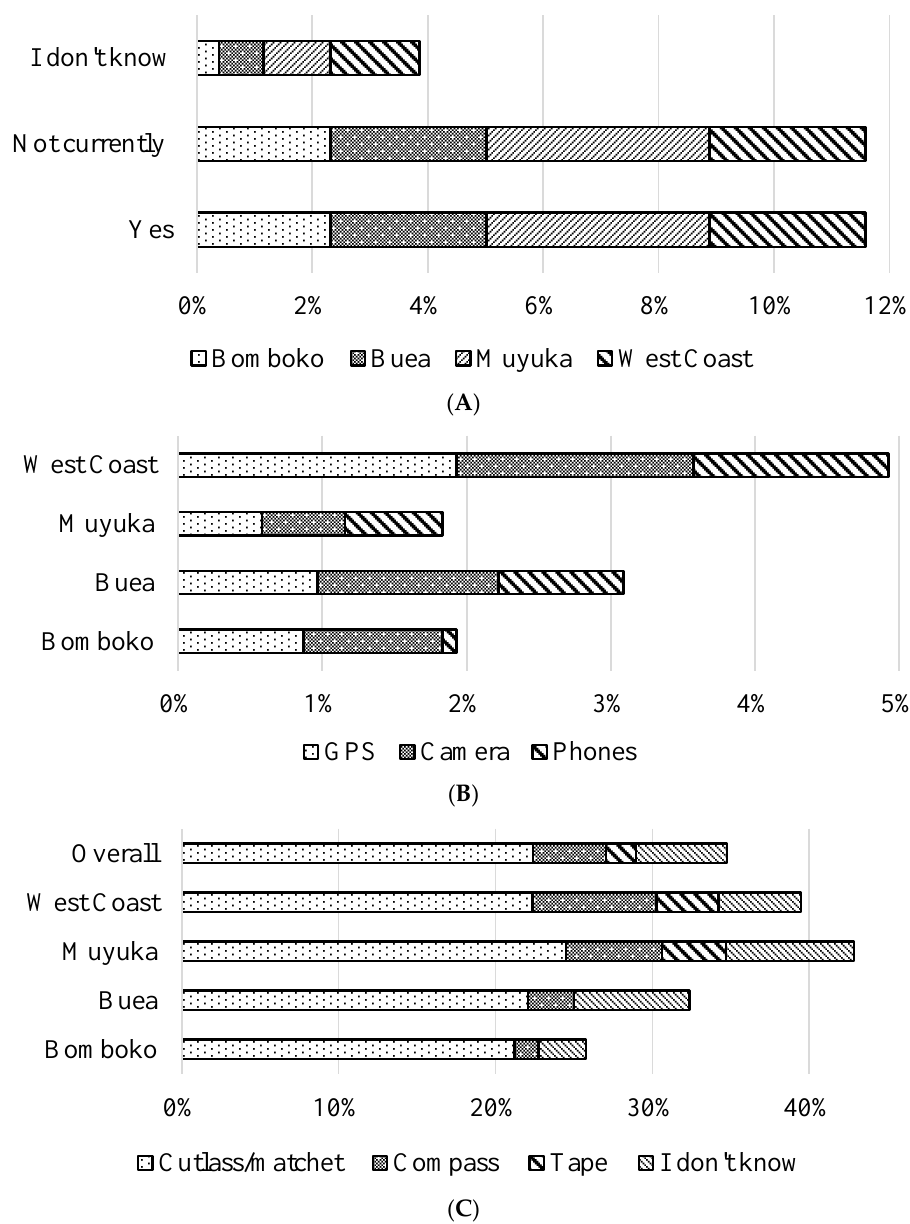
Figure 12. Percentages of electronic devices used ( A ), types of electronic devices ( B ) and non-electronic devices used ( C ) in carrying out MCNP activities.